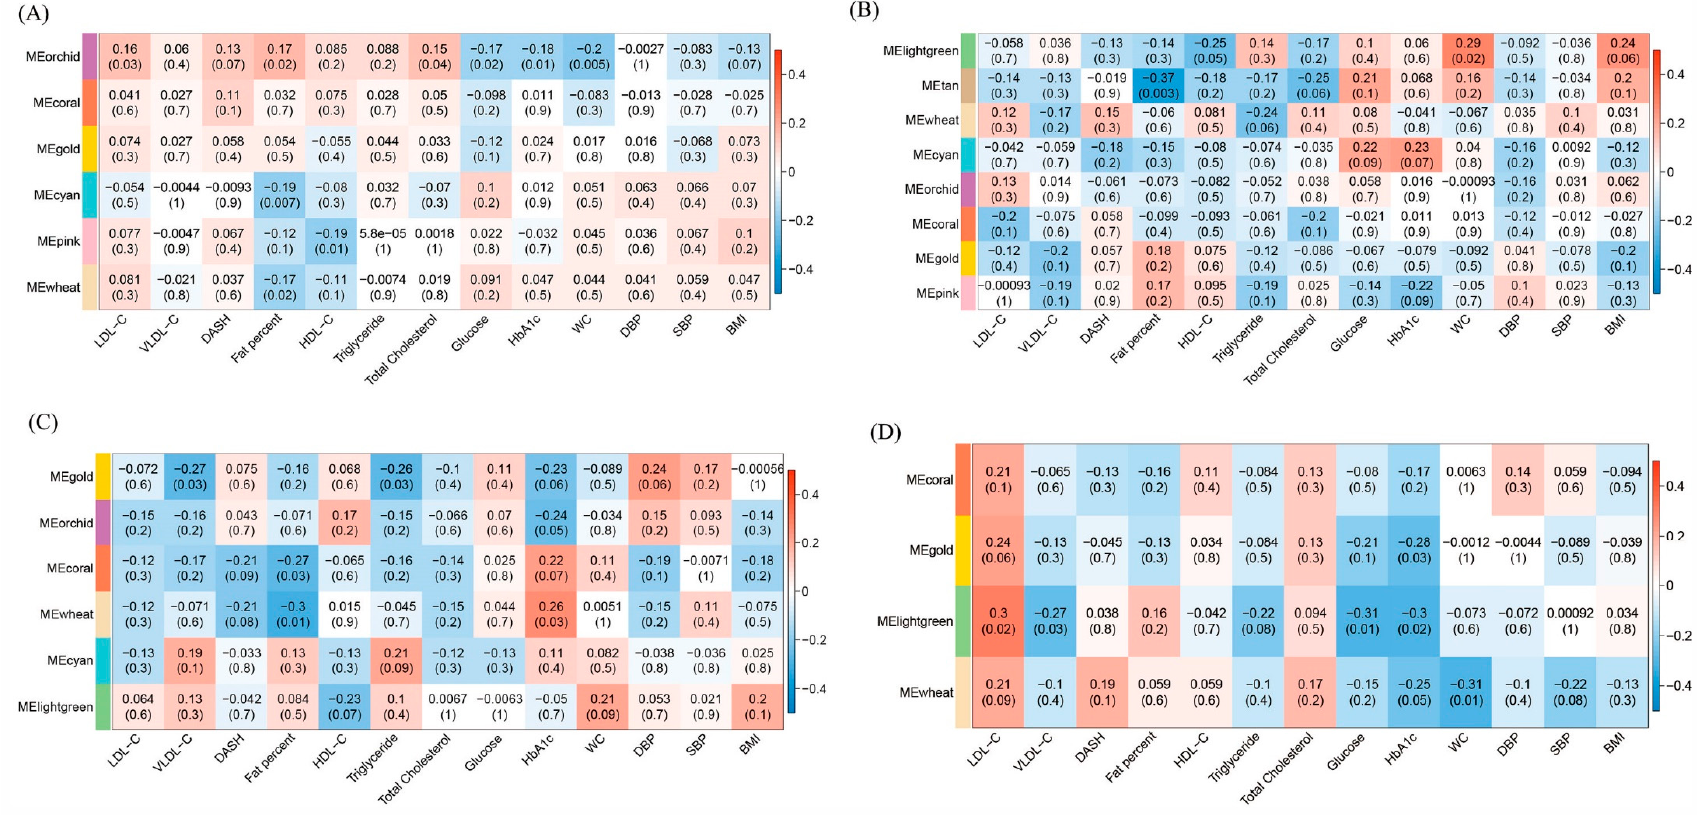
Figure 5. Module–metabolic health markers associations are shown according to metabolic health phenotype. MHNO ( A ), MUNO ( B ), MHO ( C ) and MUO ( D ). Each cell of the matrix contains the coefficient between one OTU module and a health marker, and the corresponding p value.